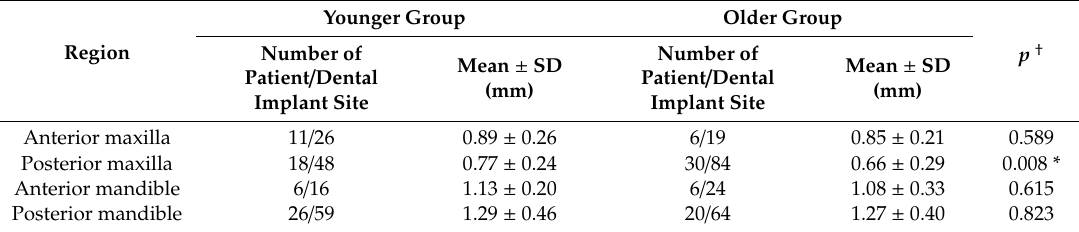
Table 1. Sample size, significance, and mean ± SD for the four jawbone regions of the younger and older